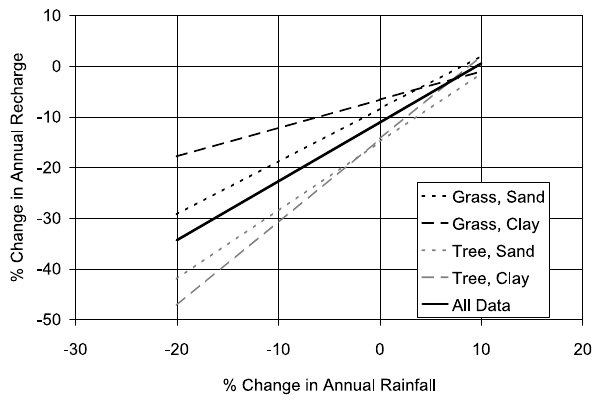
Fig. 4. Percentage change in rainfall versus percentage change in recharge to water table in PRAMS model.